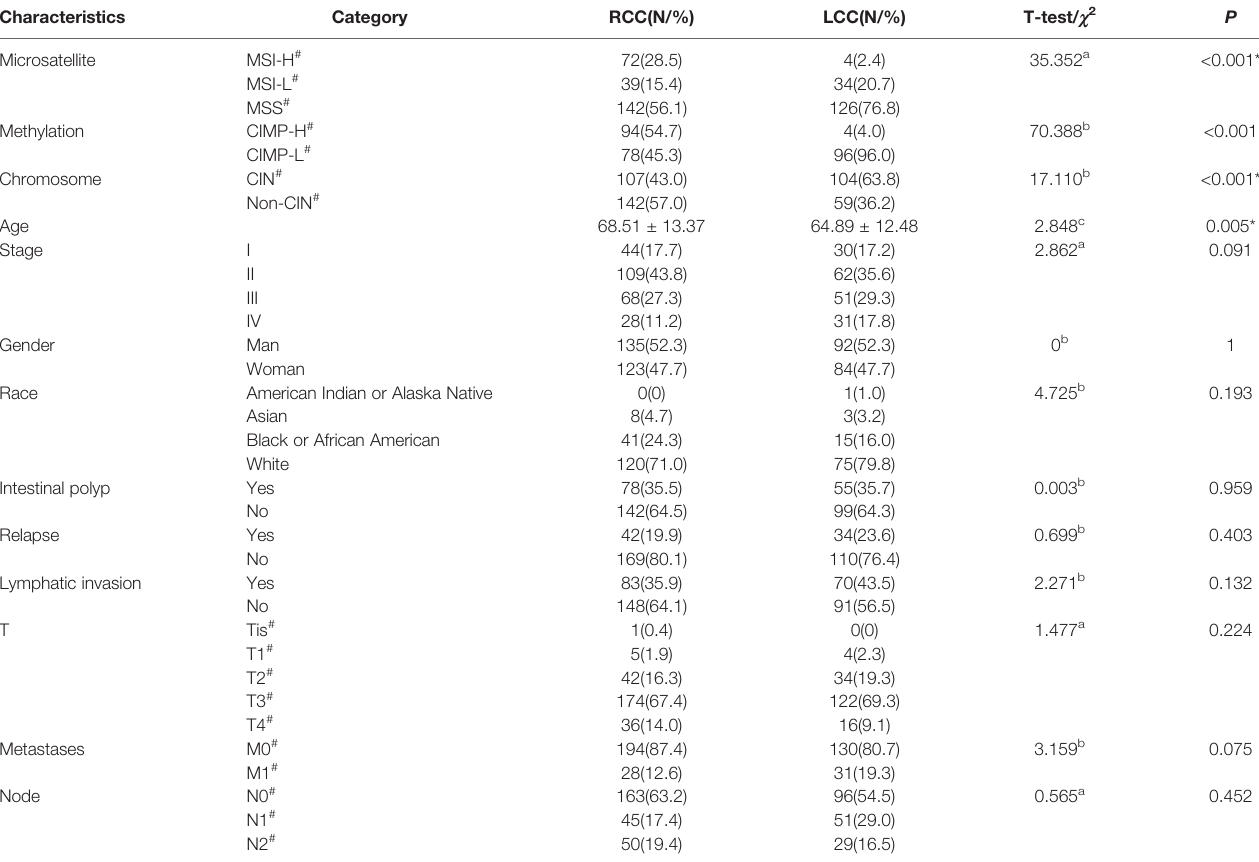
TABLE 1 | Comparison of molecular subtypes and clinical characteristics between RCC and LCC (N =434).